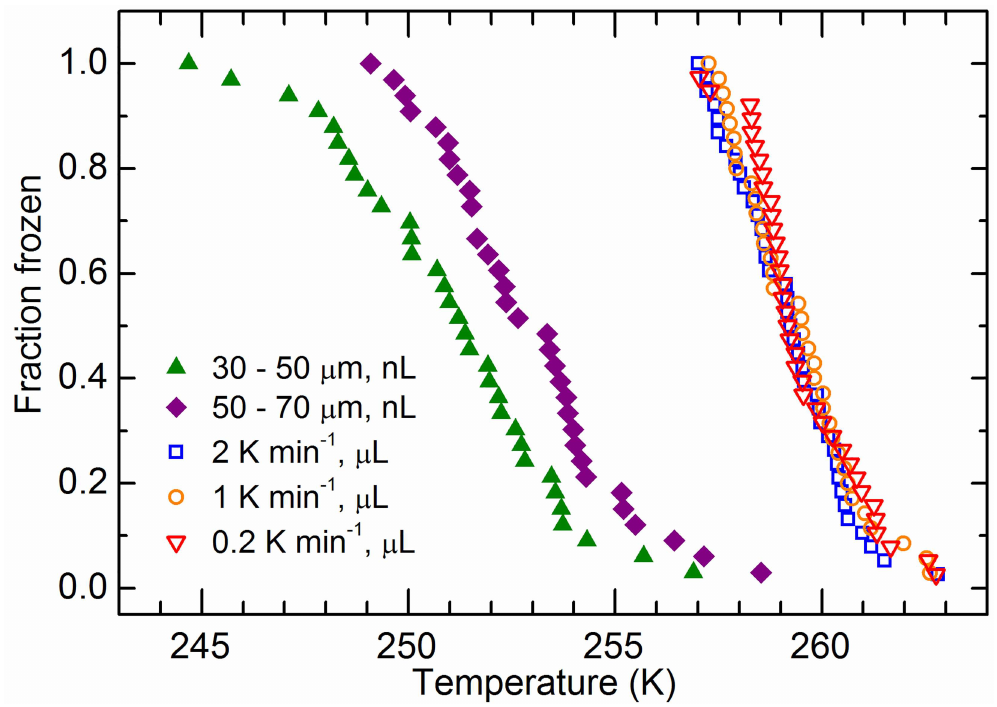
Fig 1. Fraction of droplets frozen as a function of temperaturefor nanolitre and microlitre volume supercooled water droplets containing Soufriere Hills volcanic ash particles. Droplets with diameters in the range of 30–70 μ m (nanolitrevolumes) were cooledat 10 K min -1 and had ash concentrations of 0.1 wt%. The 1 microlitre droplets had an ash concentration of 0.01 wt% and were cooledat rates from 0.2–2 K min -1